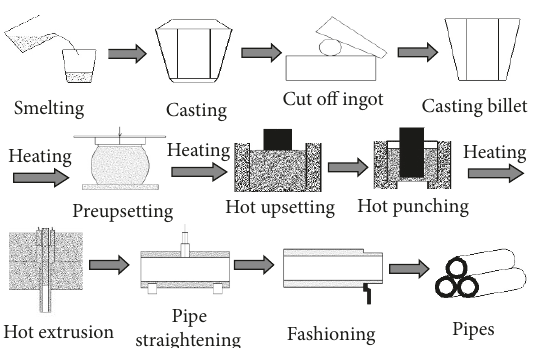
Figure 1: The punching and hot extrusion process.